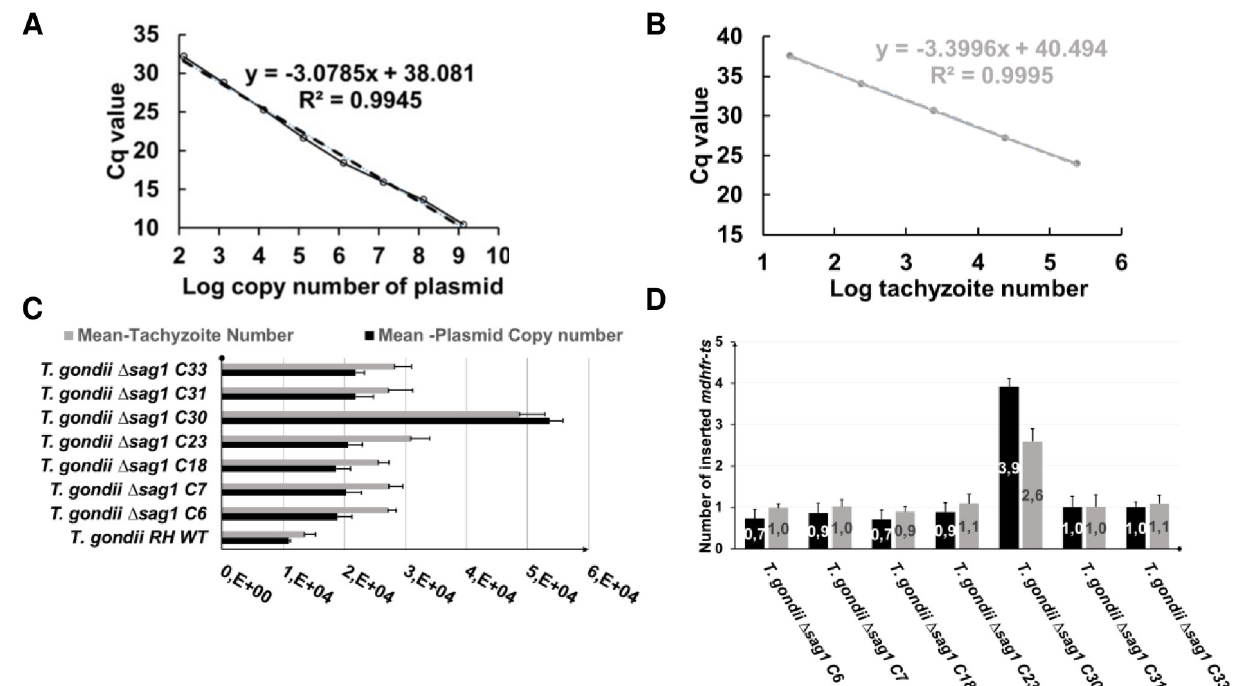
Fig 4. Single TaqMan-qPCR for determining the copy number of integrated mdhfr-ts selectable marker. Standard curves were made through a triplicate test of 10-fold serial dilutions of ( A ) P972 or ( B ) T . gondii RH DNA. ( C ) For each WT or KO clone, the number of existing dhfr-ts in the genome was determined according to the plasmid based standard curve (black bars) and the T . gondii RH DNA-based calibrator (grey bars). Since in the T . gondii genome the wtdhfr-ts is a single copy gene, the following equation was used: one WT tachyzoite = one-copy dhfr-ts , for the calculation based on T . gondii RH DNA based calibrator curve (grey bars). Error bars indicate standard deviation of triplicates for each sample. In ( D ), the number of inserted mdhfr-ts in each KO clone is defined by subtracting the dhfr-ts copy number found in the WT from the dhfr-ts copy number in the KO (black bars) or by subtracting the tachyzoite numbers determined for the WT from tachyzoite numbers corresponding the KO clone (grey bars). The optimal result of 1 indicates a single integration event of the mdhfr-ts into sag1